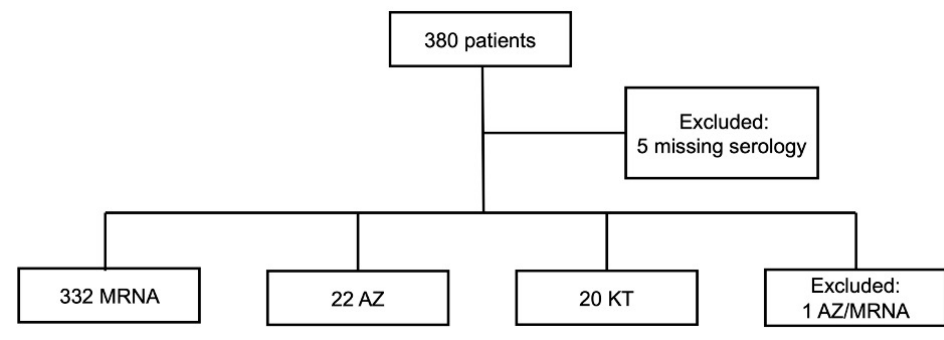
Figure 1. Flow chart of the study. Table 1. Patient characteristics according to humoral response after vaccination.